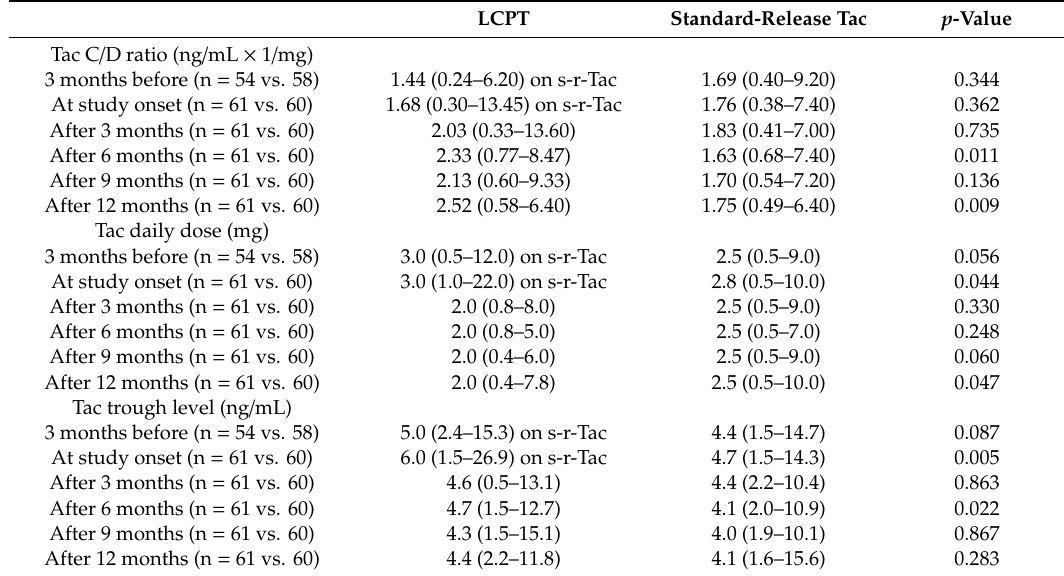
Table 3. Tacrolimus concentration / dose (C / D) ratio, daily dose and blood trough concentration. LCPT Standard-Release Tac p